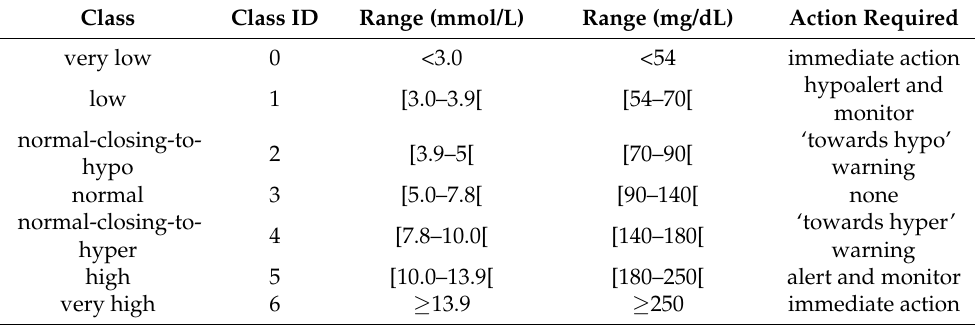
Table 3. The seven classes used for the glucose classification